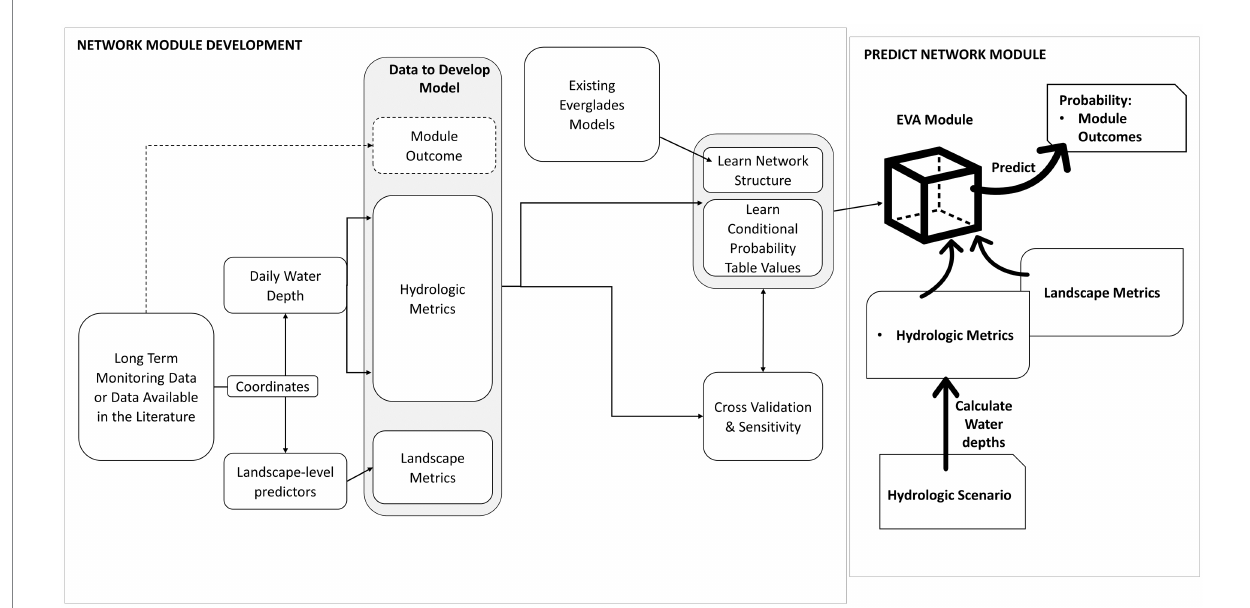
FIGURE 2 Conceptual framework detailing how each Bayesian network module was built and then predicted across the landscape. The left-hand box describes the process used to develop the module, including assessing module accuracy and sensitivity. The right-hand box describes the process used to predict the module outcomes across the